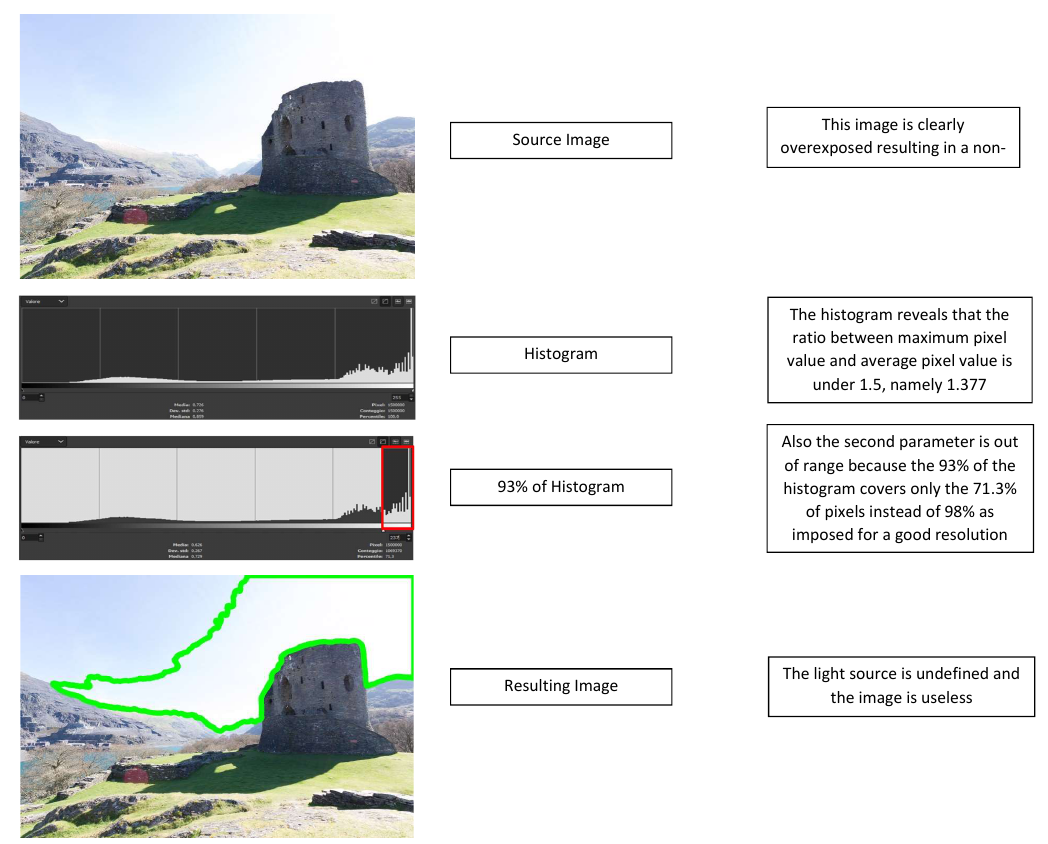
Figure 6. Example of an overexposed image not suitable for the proposed